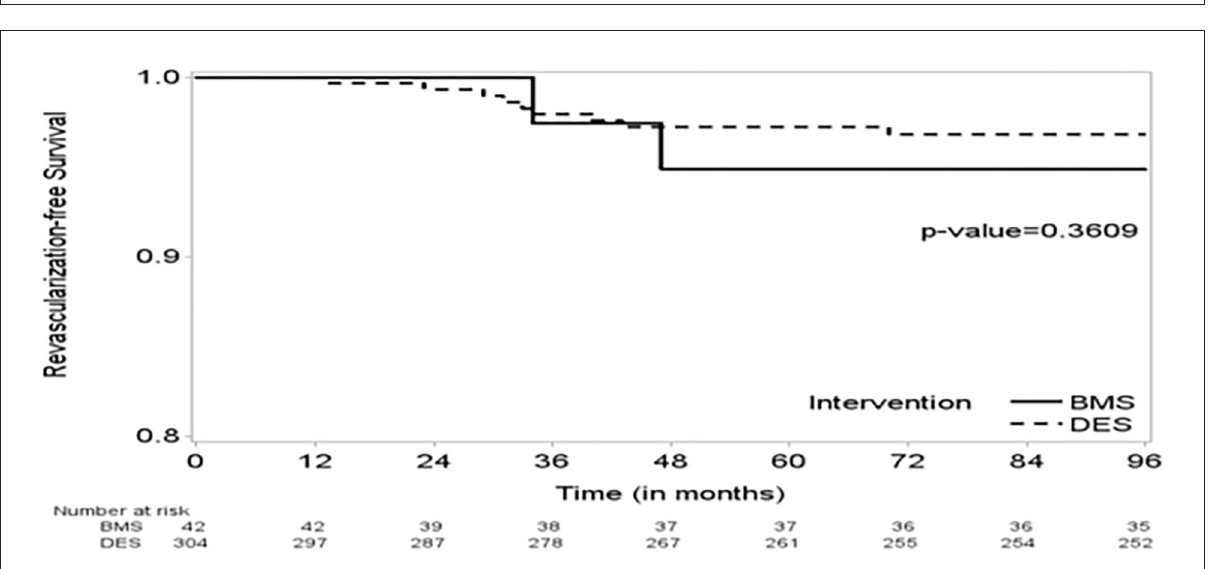
FIGURE2 The Kaplan–Meier (KM) curve on time to revascularization shows no significant difference in time to revascularization between the BMS and DES groups.